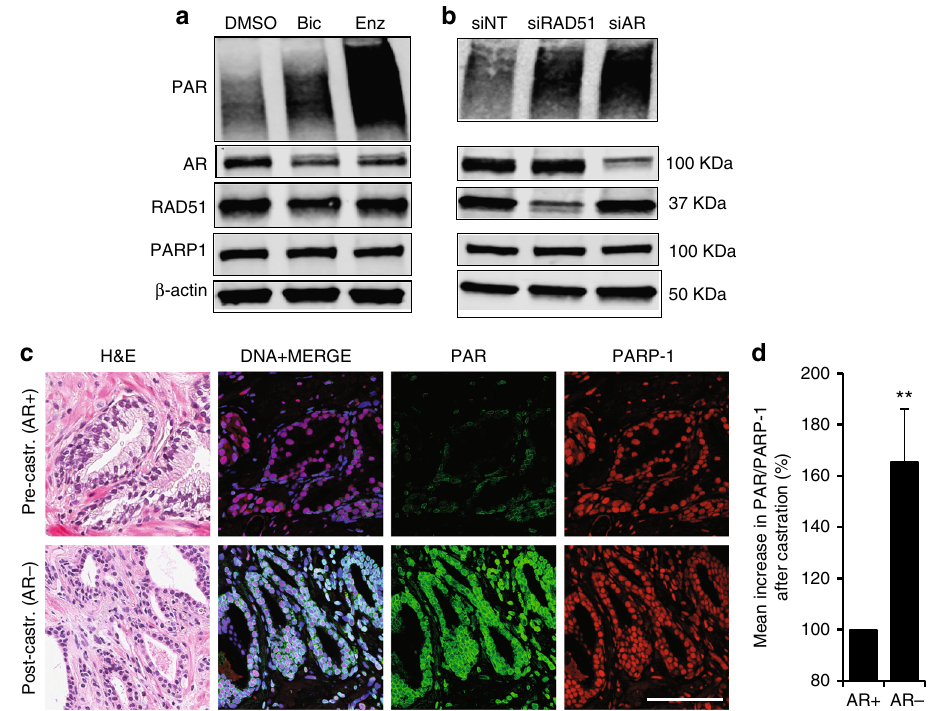
Fig. 2 Androgen deprivation therapy triggers PARP activation. a Western blot showing C4-2 cells treated for 72 h with indicated agents (10 µ M). b Western blot showing C4-2 cells transfected with indicated siRNA (20 nM). c Immuno fl uorescence microscopy images showing relative intensities of PAR Poly(ADP Ribose) and PARP1 (Poly ADP-ribose polymerase 1) in PCa tissue pre- (pre-castration or AR+) and post leuprolide (post-castration or AR-) treatment (8 weeks). Scale bar = 100 μ m. d Histogram shows PARP activity in PCa patients pre- and post-leuprolide treatment (One sample t-test, two- tailed, test value